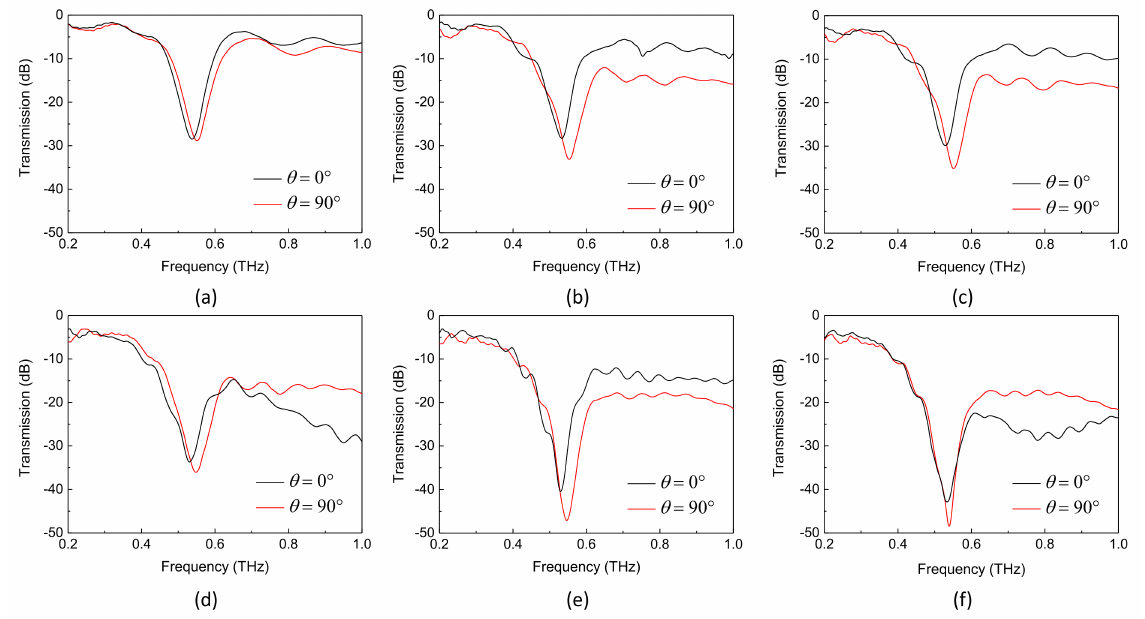
Figure 6. Terahertz spectra of metamaterial cells with various LC thicknesses of ( a ) 310 µ m, ( b ) 500 µ m, ( c ) 710 µ m, ( d ) 1000 µ m, ( e ) 1300 µ m, and ( f ) 1487 µ m at θ = 0 ◦ and 90 ◦ .